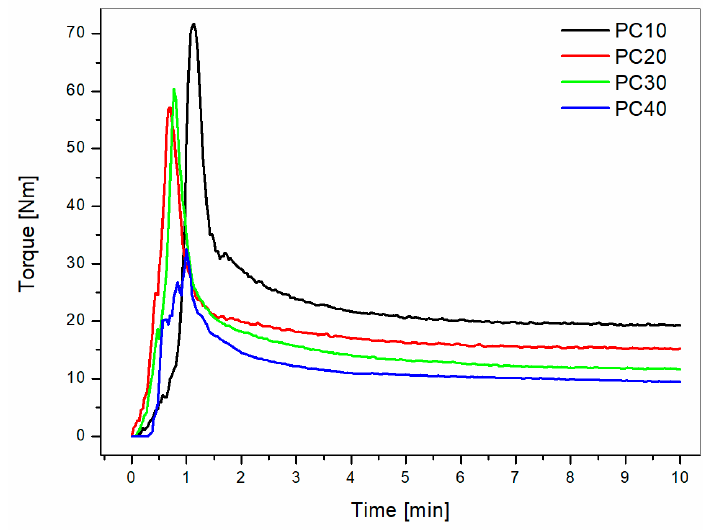
Figure 3. Torque versus time curves for PEI/PC blends mixed at 300 °C for different PC contents.